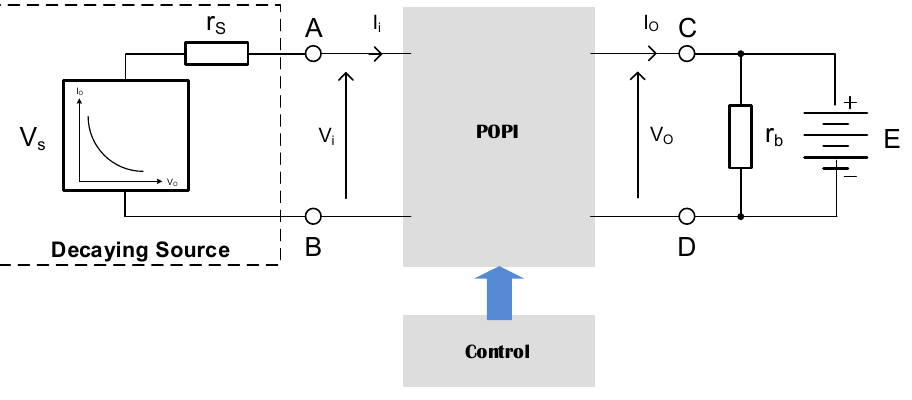
Figure 15. A decaying source coupled to a storage battery by a general POPI network.